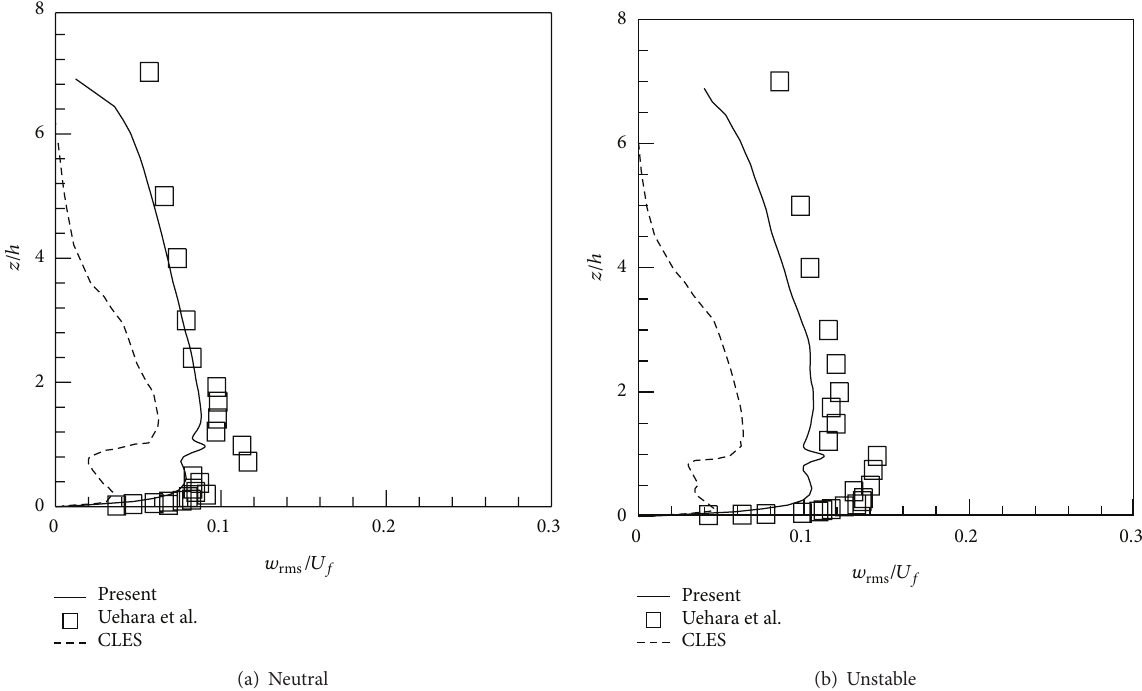
Figure 7: Vertical profiles of vertical turbulence intensity 𝑤